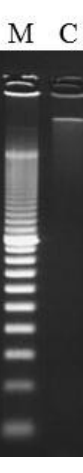
Figure 7. Analysis of DNA fragmentation patterns by agarose gel electrophoresis. DNA was extracted from HL-60 cells incubated with 0.5 mg ・ mL −1 fruit ethanol extract for 6 h. M: DNA marker, C: control, 1: Shashanbo ( Vaccinium bracteatum Thunb.), 2: Natsuhaze ( V. oldhamii